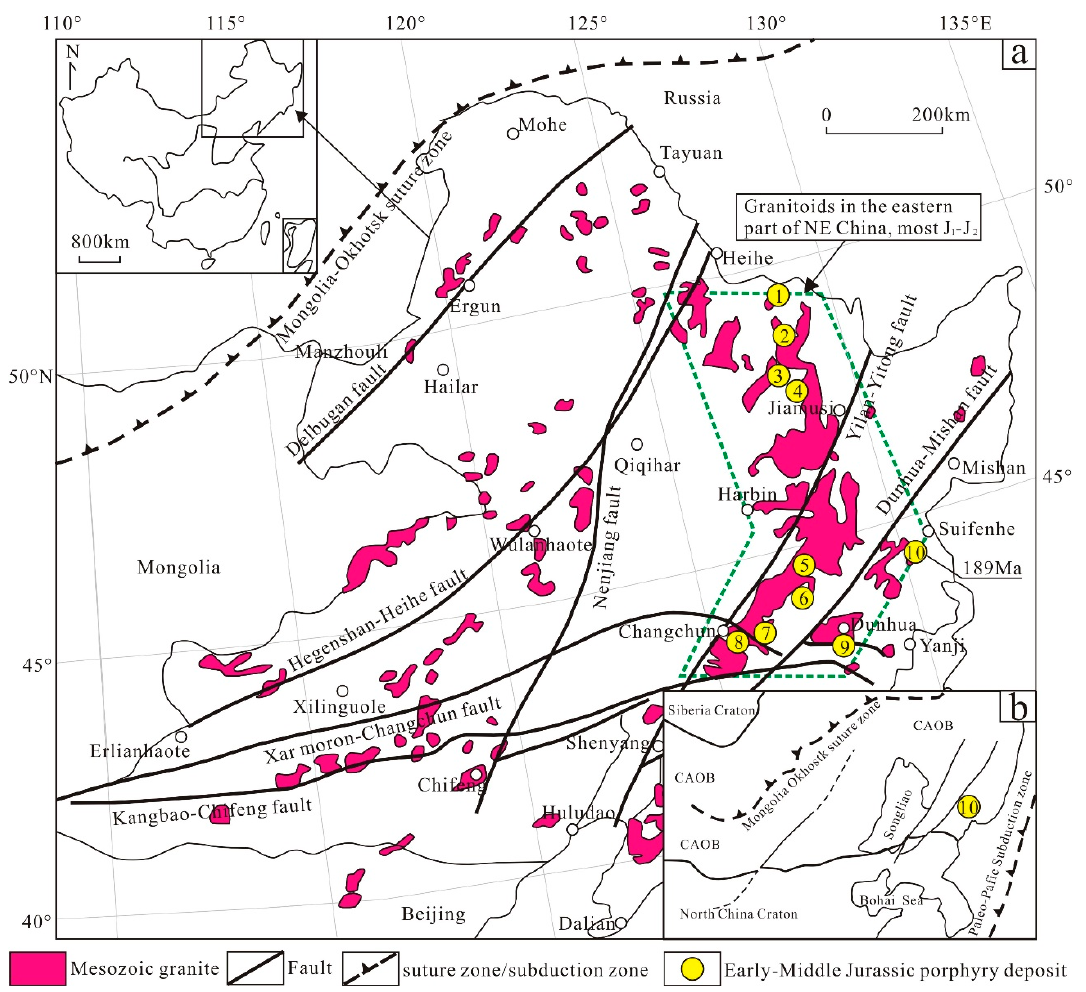
Figure 7. ( a ) Distribution of Mesozoic granites and Early–Middle Jurassic porphyry deposits in NE China [46], ( b ) the position of the Mongolia–Okhotsk suture zone and Paleo-Pacific Subduction zone relative to the study area [47,48]. 1—CuiHongshan, 2—Huojihe, 3—Cuiling, 4—Luming, 5—Fu’anbao, 6—Jidetun, 7—Daheishan, 8—Lanjia, 9—Liujiadian, 10—Yanghuidongzi. The CAOB is the